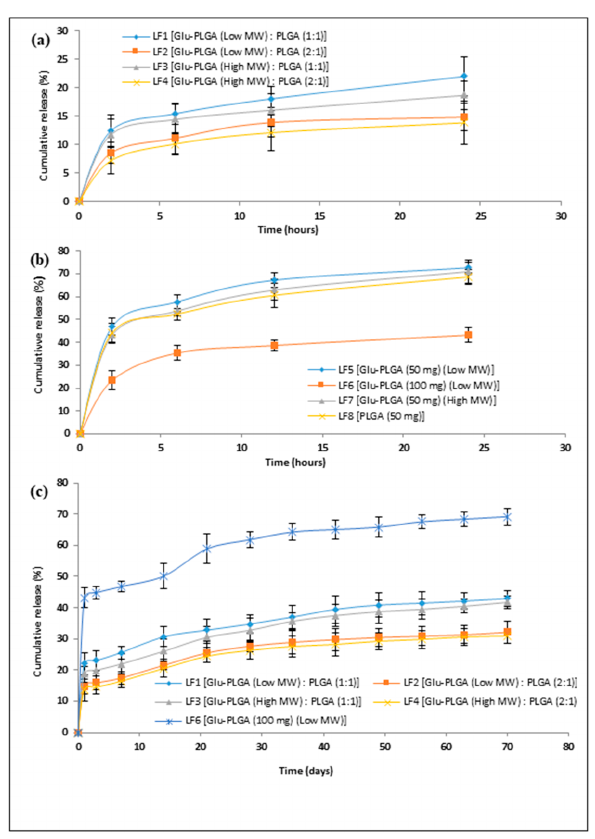
Figure 3. In vitro release profiles of lysozyme for ( a ) 24 h double-walled; ( b ) 24 h single-walled; and ( c ) 70 days double-walled and single-walled microspheres prepared in different formulations. The data are presented as mean ± SD ( n =